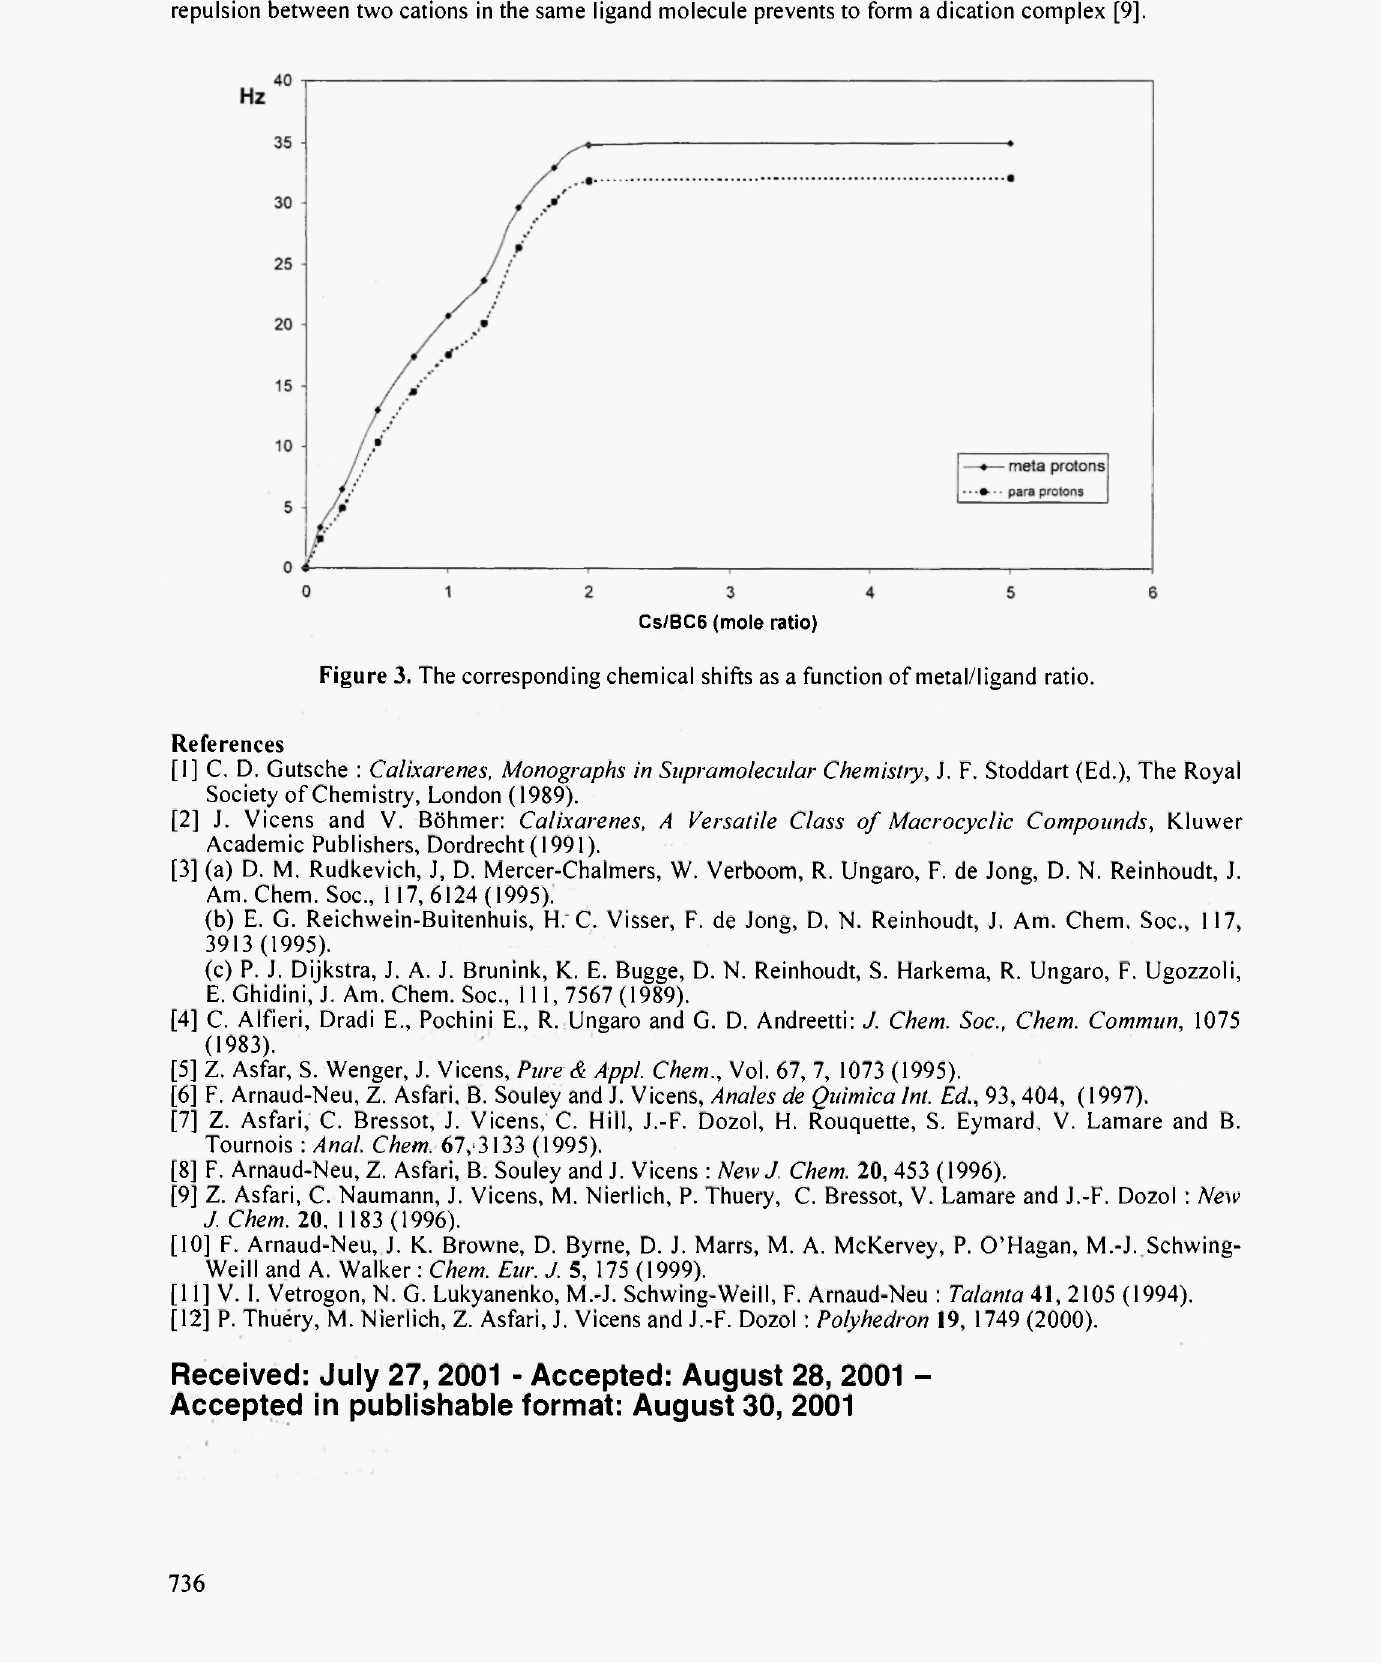
Figure 3. The corresponding chemical shifts as a function of metal/ligand